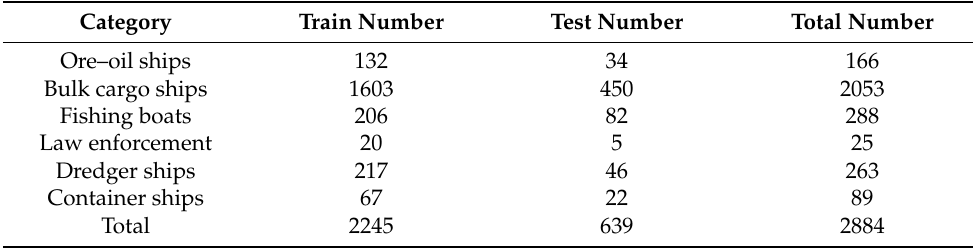
Table 2. The number of each ship category in